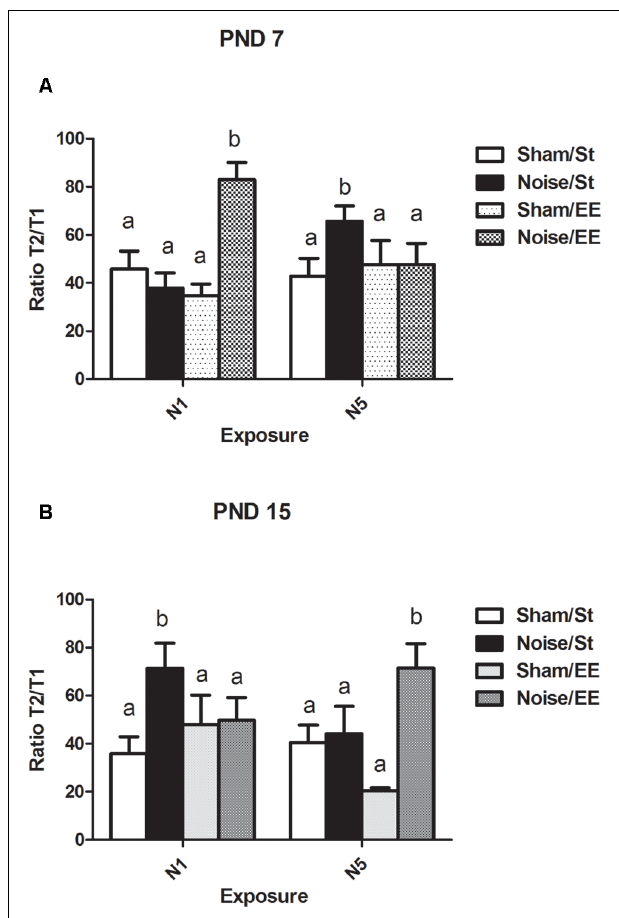
FIGURE 8 | Ratio between the latency to enter the dark compartment (in seconds) in the retention session and the training session (T2/T1) in the inhibitory avoidance (IA) task in PND28 animals exposed to noise at PND7 and PND15. (A) PND28 animals exposed at PND7; (B) PND28 animals exposed at PND15. Sham: non-exposed animals; N1: single noise exposure; N5: five-daily noise exposure. St: standard housing. EE: enriched environment. Different letters (a, b) symbolize significant differences with p < 0.05. Data represent the mean ± SEM of T2/T1in the IA task, n = 7 for each